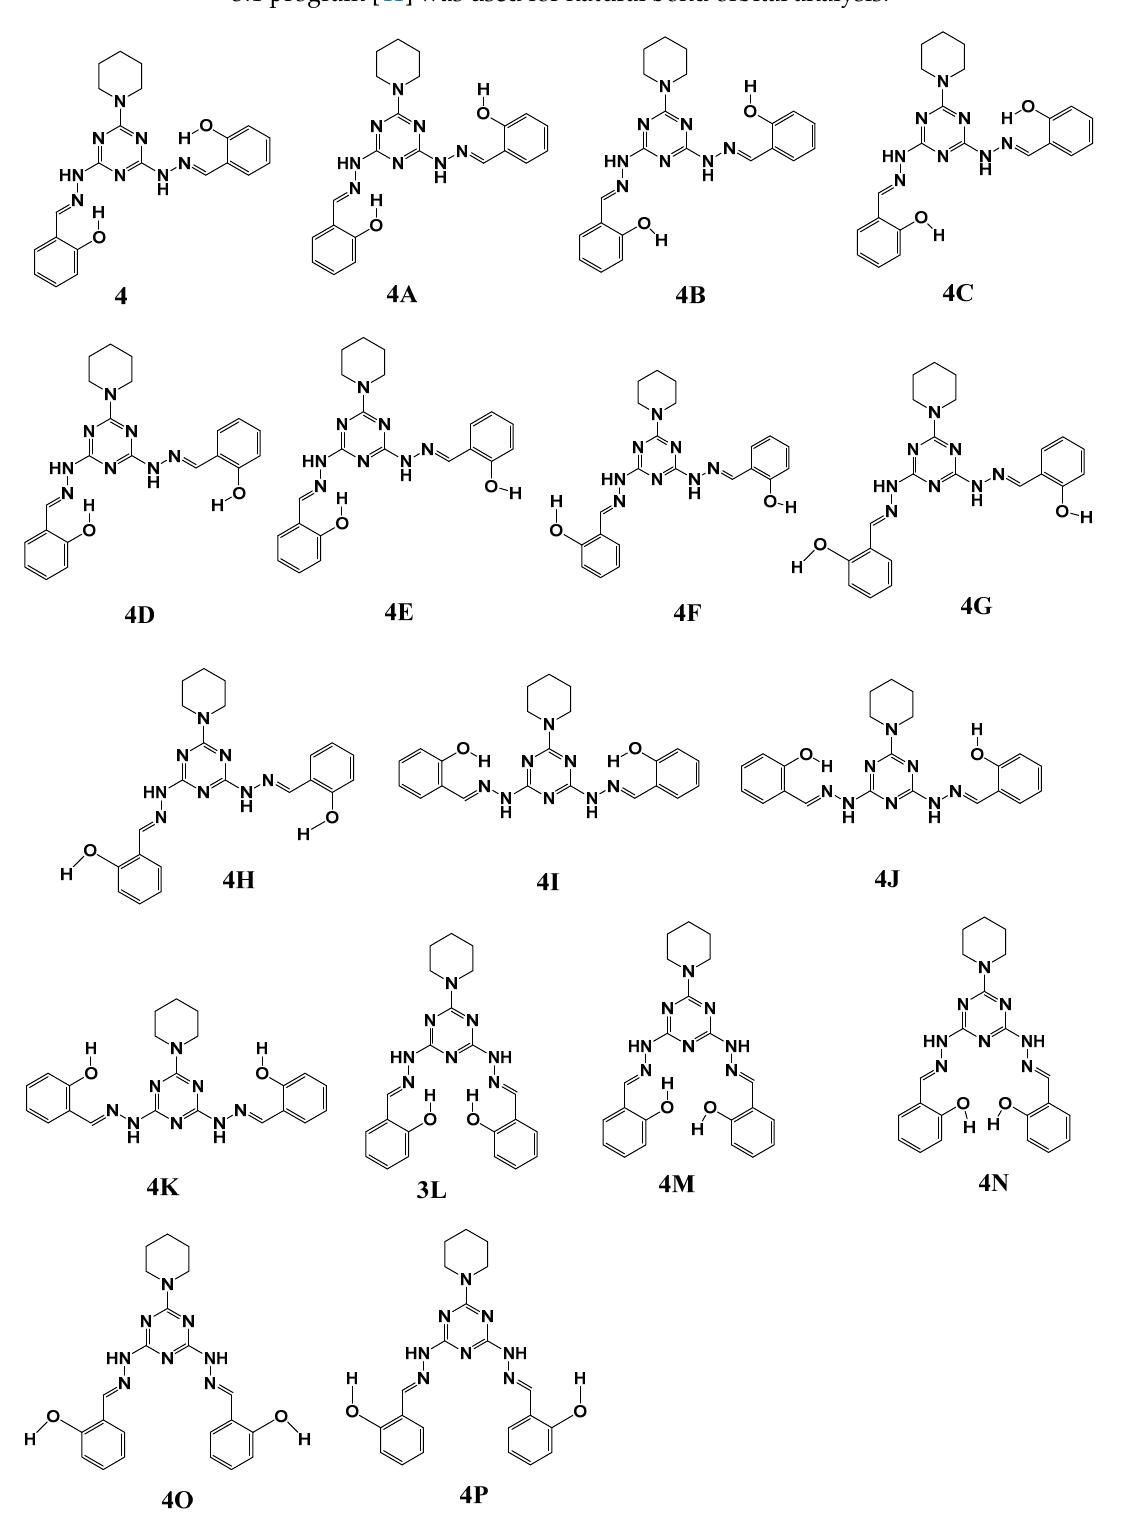
Figure 2. The suggested conformers of the s -triazine bis -Schiff base; 4 .